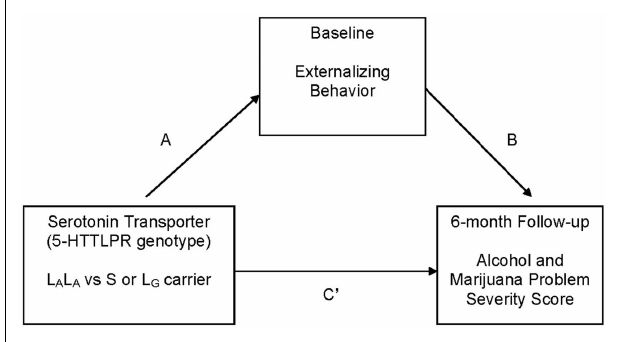
FIGURE 1 | Hypothesized mediation (indirect effects) model that was tested . C (cid:48) represents the direct effect of independent variable (5-HTTLPR genotype: high vs. low expressing) on the dependent variable (alcohol and marijuana problem severity at 6months) after controlling for the intervening variable (externalizing behavior).The C path (not labeled in the figure) represents the total effect of the independent variable on the dependent variable. Covariates: gender, age, race (Caucasian vs. all other ethnicity), socio-economic status, and baseline frequency of substance use.